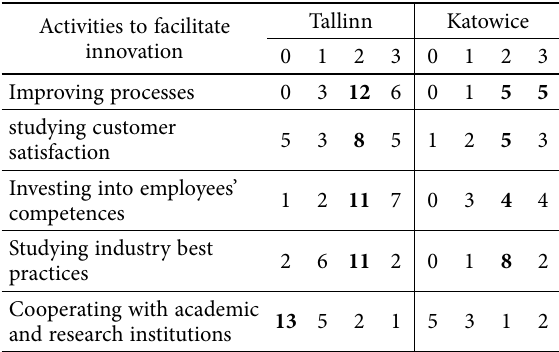
Table 9. Activities to facilitate innovation in the air